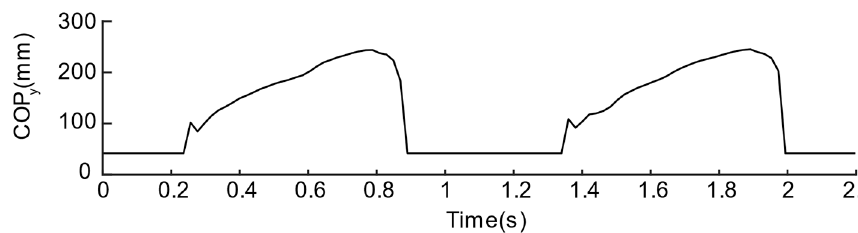
Figure 12. COP values of the first insole solution.